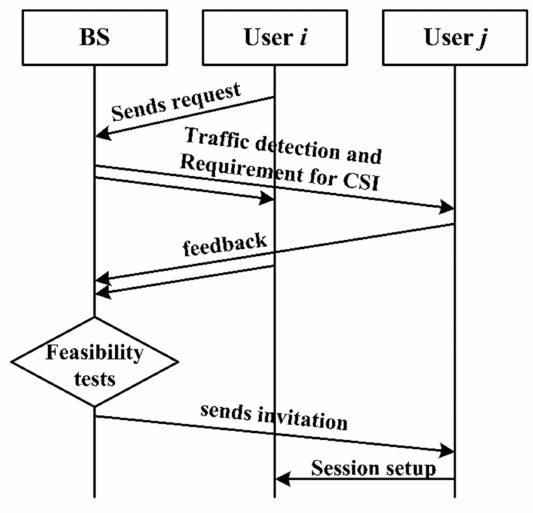
Figure 2. Session setup of D2D